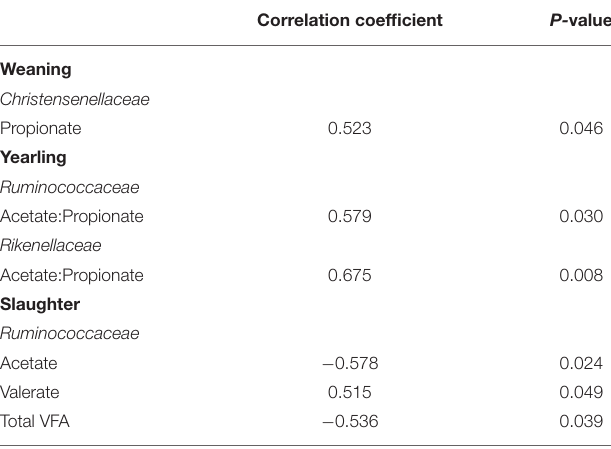
TABLE 4 | Correlation between volatile fatty acids concentration and bacterial families* in the feces of steers ( n = 15) at weaning, yearling, and slaughter. Correlation coefficient P-